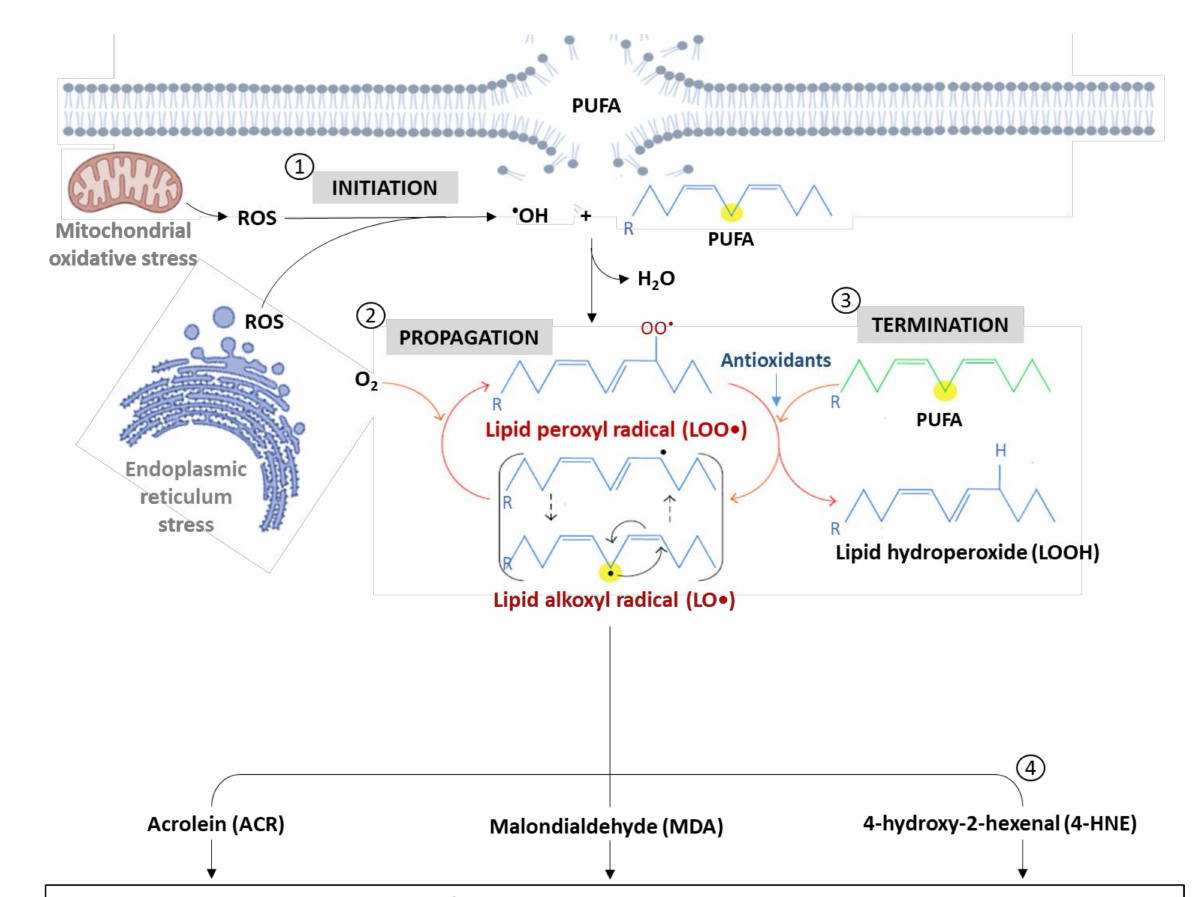
Figure 1. An overview of pathological mechanisms of lipid peroxidation, especially highlighting the formation of lipid aldehydes. Briefly, the different steps, indicate ( ➀ ) Initiation, ( ➁ ) Propagation ( ➂ ) termination, and ( ➃ ) formation ACR, MDA and 4-HNE. Abbreviations; PUFA: polyunsaturated fatty acid; ROS: reactive oxygen species; MDA: malondialdehyde; 4-HNE: 4-hydroxy-2-nonenal; • OH: hydroxyl radical; LO • : lipid alkoxyl radical; LOO • : lipid peroxyl radical; LOOH: lipid hydroperoxide. NB: Yellow dot indicated a point where oxidation